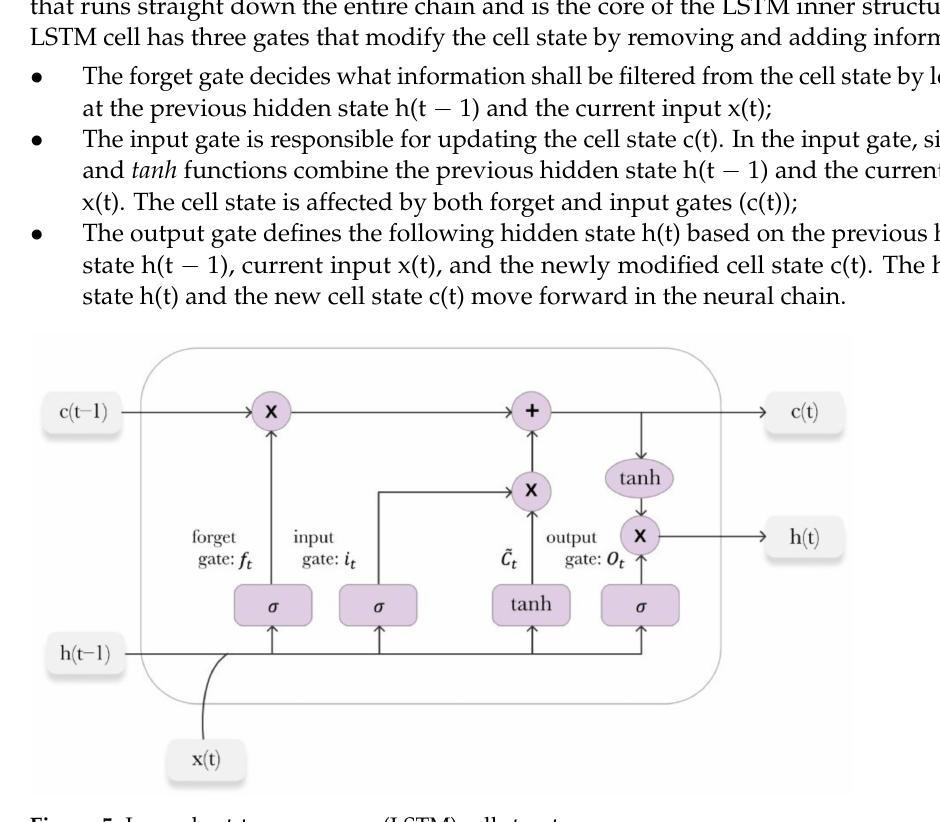
Figure 5. Long short-term memory (LSTM) cell